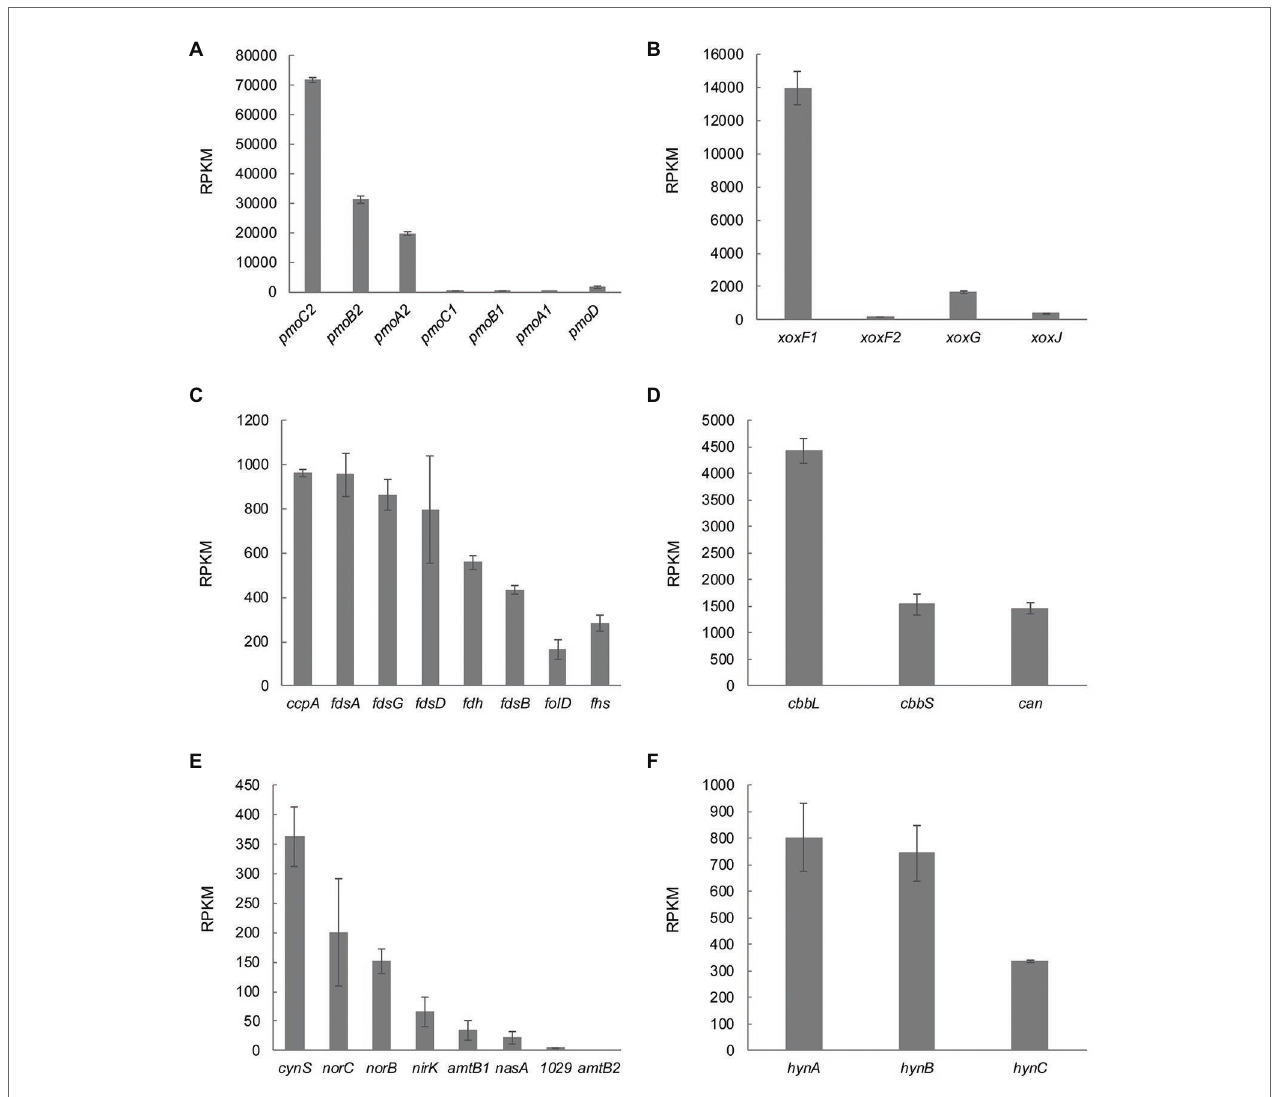
FIGURE 6 | Transcriptomic profile of genes involved in carbon, nitrogen and hydrogen metabolism. (A) The particulate methane monooxygenase is encoded by two different operons in M. thermophilum AP8. At maximum growth rate, pmoCAB2 is expressed. (B) Expression of the lanthanide dependent methanol dehydrogenase genes xoxF1 and xoxF2 and of the genes encoding the cytochrome c ( xoxG ) and the periplasmic substrate binding protein ( xoxJ ). (C) M. thermophilum AP8 encodes for different formate dehydrogenases and for genes involved in the tetrahydrofolate pathway ( folD, Methylenetetrahydrofolate dehydrogenase/Methenyltetrahydrofolate cyclohydrolase; fhs, Formate-tetrahydrofolate ligase). (D) cbbL and cbbS correspond to genes encoding the large and small subunit of the Ribulose-1,5-bisphosphate carboxylase oxygenase (RuBisCO); can , carbonic anhydrase. (E) cynS , cyanate hydratase; norC , nitric oxide reductase subunit C; norB , nitric oxide reductase subunit B; nirK , nitrite reductase; amtb1 and amtb2 , ammonium transporters; nasA , nitrate transporter; 1029, MTHMO_v1_1029, assimilatory nitrate reductase/nitrite reductase. (F) Expression of the three subunits of the type 1b [NiFe] hydrogenase. A list of all genes with relative RPKM values can be found in Supplementary Table S4